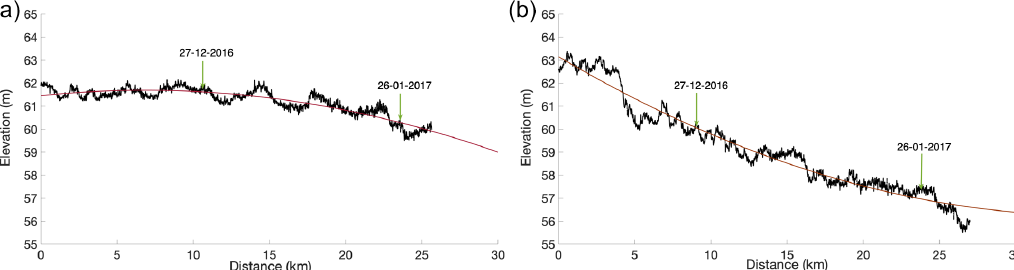
Figure 9. Elevation profiles for (a) the WS and (b) the ES. Quadratic trend lines are shown in red. Data are extracted from REMA (Howat et al., 2019), and the path of data extraction was guided using the maximum depth matrix of both the WS and ES over the full 2016–2017 melt season (see Fig. S5). The labelled green arrows mark the down-ice extent of each system on 27 December 2016 and 26 January 2017.